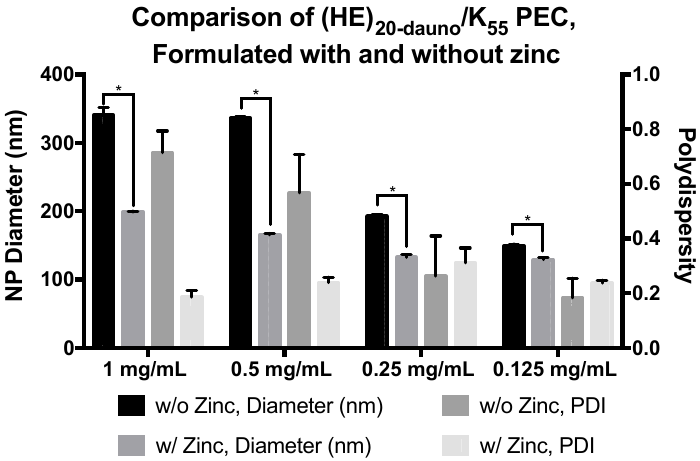
Figure 7. Comparison of PEC formulated from (HE) 20-dauno and K 55 with and without zinc. PEC formulated from (HE) 20-dauno /K 55 with zinc were significantly smaller at all concentrations tested than those without zinc. There was a corresponding decrease in polydispersity that was most apparent at the 1 mg/mL and 0.5 mg/mL formulations, however, it was not statistically significant. Data shown are averages of four wells ± standard deviation. Results were analyzed by two-way ANOVA with p < 0.0001 indicated (*).